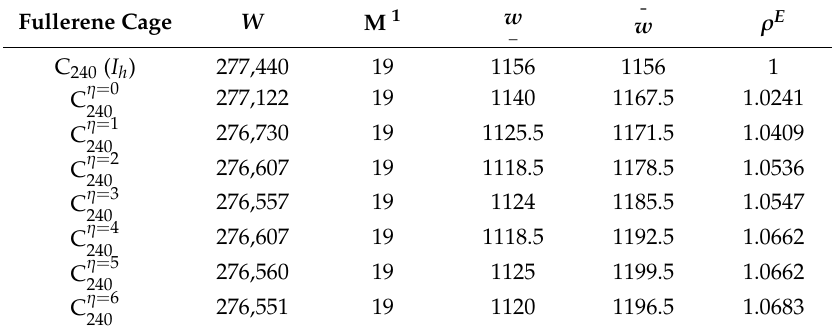
Table 2. Topological descriptors of the original and defected C 240 fullerenes.